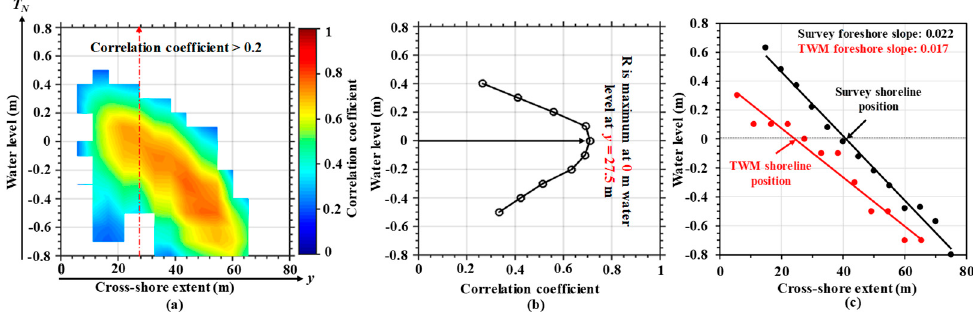
Figure 9. An example Temporal Waterline Method (TWM) detected beach profile at x = − 49 m during 17–30 June 2005. ( a ) The distribution of correlation coefficients for different tidal signals ( − 0.8 to 0.8 m) and cross-shore positions ( 0 ≤ y ≤ 80 m ) . ( b ) The correlation coefficients for different tidal binary signals at y = 27.5 m. The maximum correlation is established at water level 0.0 m. ( c ) The intertidal beach profile determined by linear regression. The shoreline position ( y = 24.3 m) is defined at water level 0.0 m, and the black regression line indicates the survey intertidal beach profile on 17 June 2005.